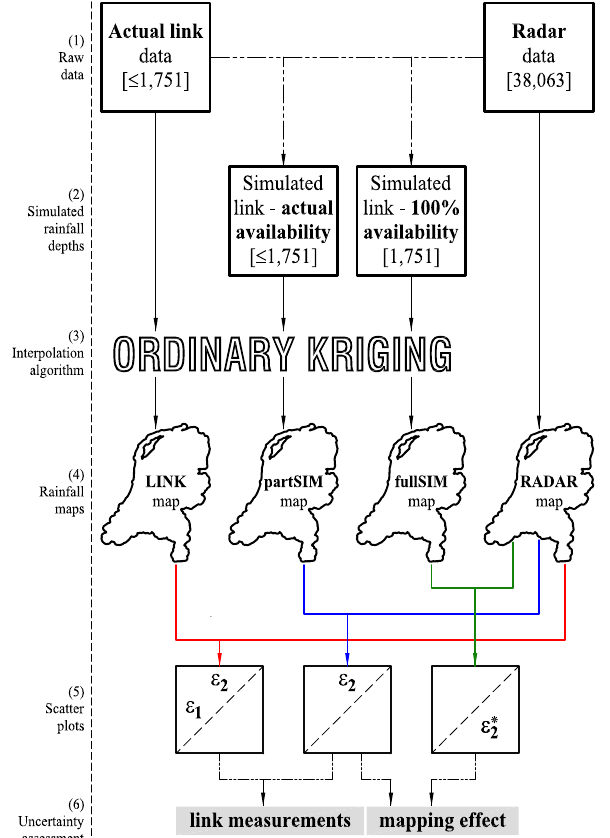
Figure 1. Flowchart to visualize the hierarchical process to iden- tify and quantify uncertainties in rainfall maps from link networks. From top to bottom: (1–2) raw data are selected and rainfall depths simulated; (3–4) through the interpolation methodology rainfall maps are obtained; (5) from the comparison between rainfall maps scatter plots are created; and (6) from the comparison between these scatter plots (and their metrics), the error sources are quantified. ε 1 and ε 2 represent the categories in which the sources of error are classified. Specifically, ε 1 indicates the error from microwave link rainfall retrievals, and ε 2 indicates the error related to mapping. ε ∗ indicates the best case for the mapping-related error (i.e. all links are available all of the time). The number between brackets (1–2) indicates the number of data for every single map or data set.